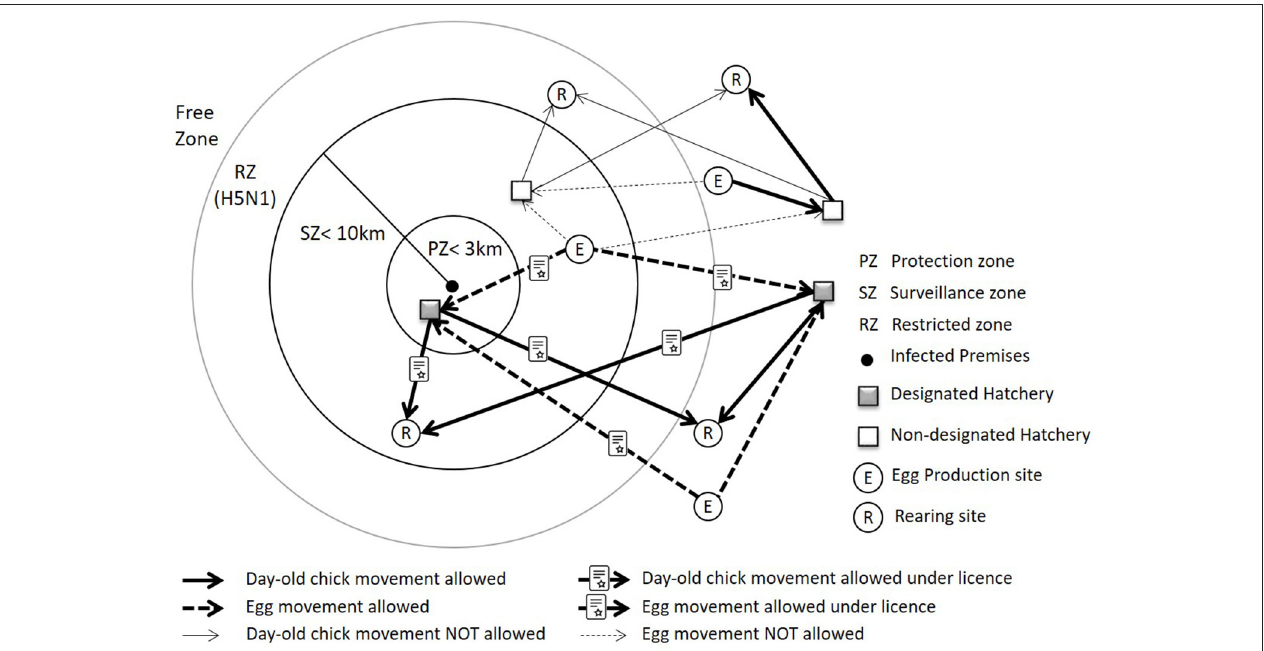
FIGURE 3 | Disease control zones during an outbreak, and illustration of allowed and not-allowed movement of eggs and day-old chicks within and between the